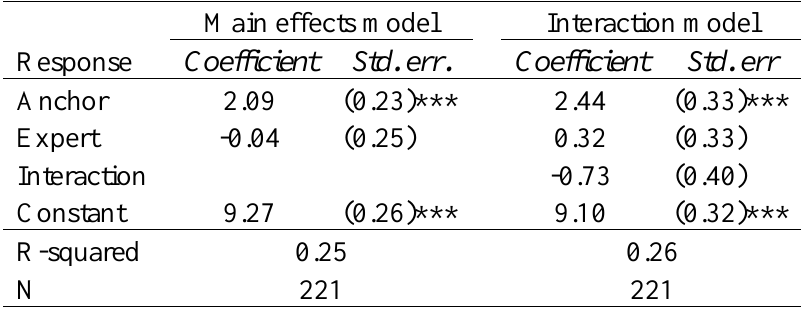
OLS Regression Results for Minimum Wage Quiz Main effects